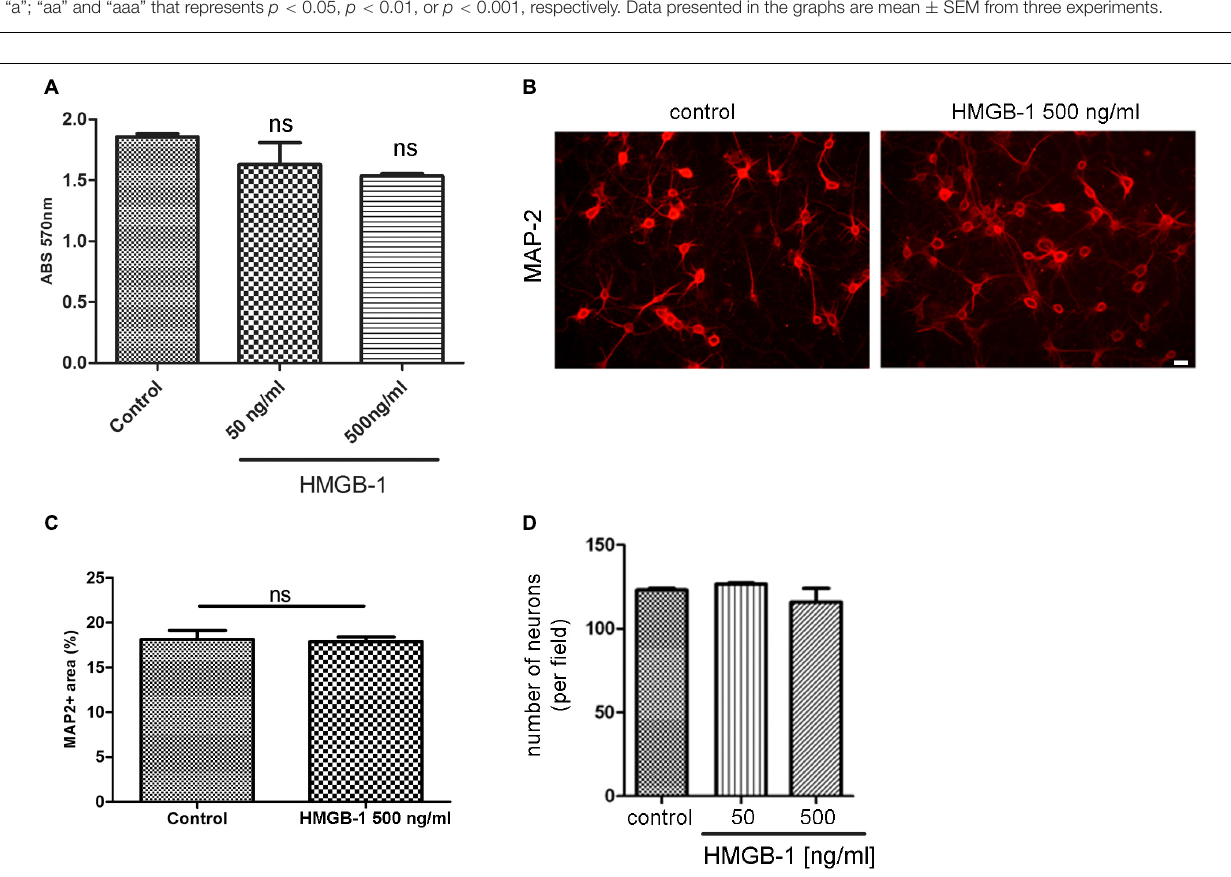
FIGURE 2 | HMGB-1 effects in primary neuronal cultures. (A) Quantitative analysis of rat primary cortical neuron survival exposed to HMGB-1 during 24 h and analyzed by the MTT survival assay with results shown as absorbance at 570 nm. (B) Representative images of rat primary cortical neurons exposed to HMGB-1 (500 ng/ml) for 24 h and immunostained for MAP-2; bar = 10 µ m. (C) Quantitative analysis of the area occupied by MAP-2 + neurons after exposure to 500 ng/ml HMGB-1. (D) Number of neurons showing normal nuclei per microscopic field analyzed by MAP-2 and DAPI co-staining after 24 h of exposure to HMGB-1 as indicated. Statistical analyses were performed by one way ANOVA. Data presented in the graphs are mean ± SEM from three